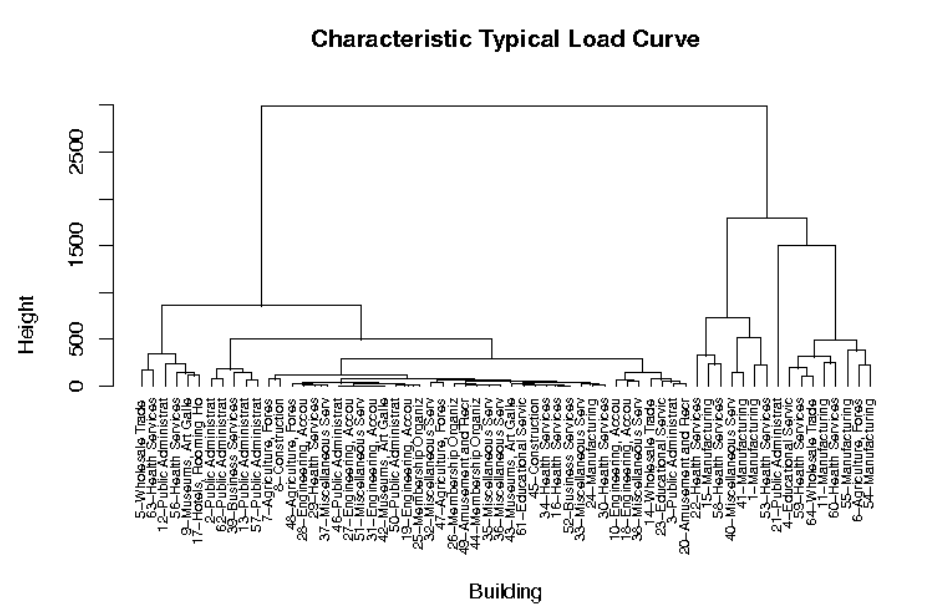
Figure 8. Classification of customers based on the characteristic typical load